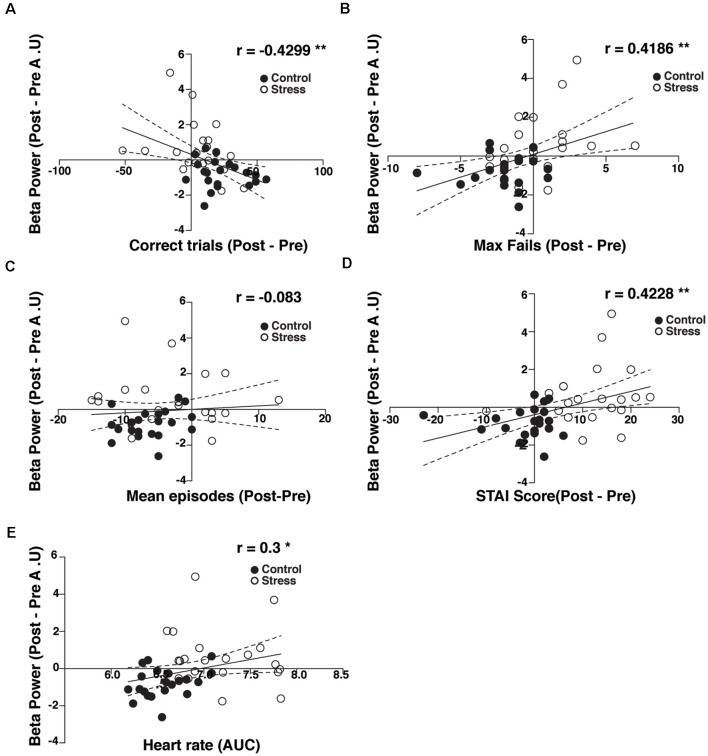
Relationship between beta power, performance, and stress outcomes. (A) Person correlation between beta power difference and correct trials. (B) The maximal number of consecutive fails. (C) The number of episodes with two or more consecutive fails. (D) Self-reported state of anxiety. (E) Heart rate (area under the curve). *p < 0.05, **p < 0.01.